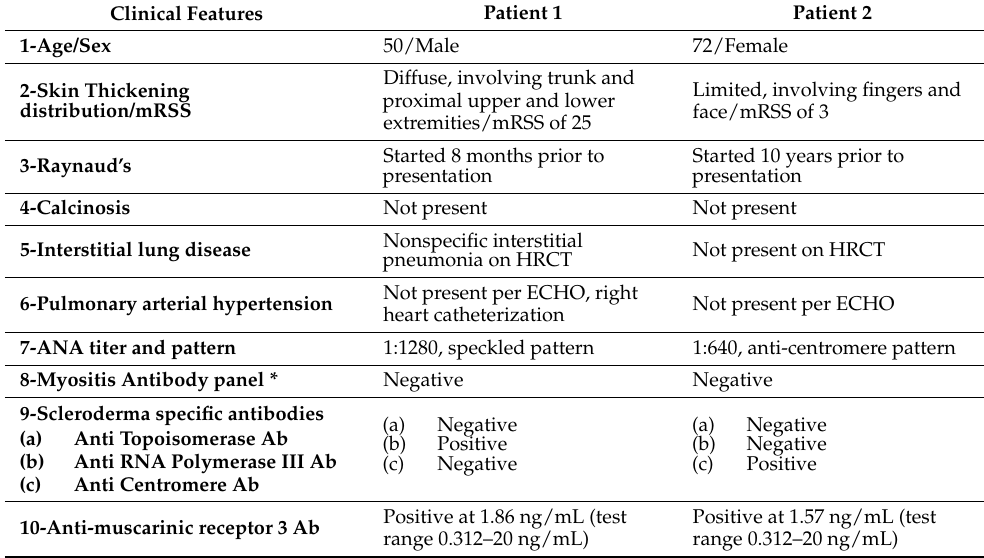
Table 1. Clinical Features of SSc patients prior to IVIG